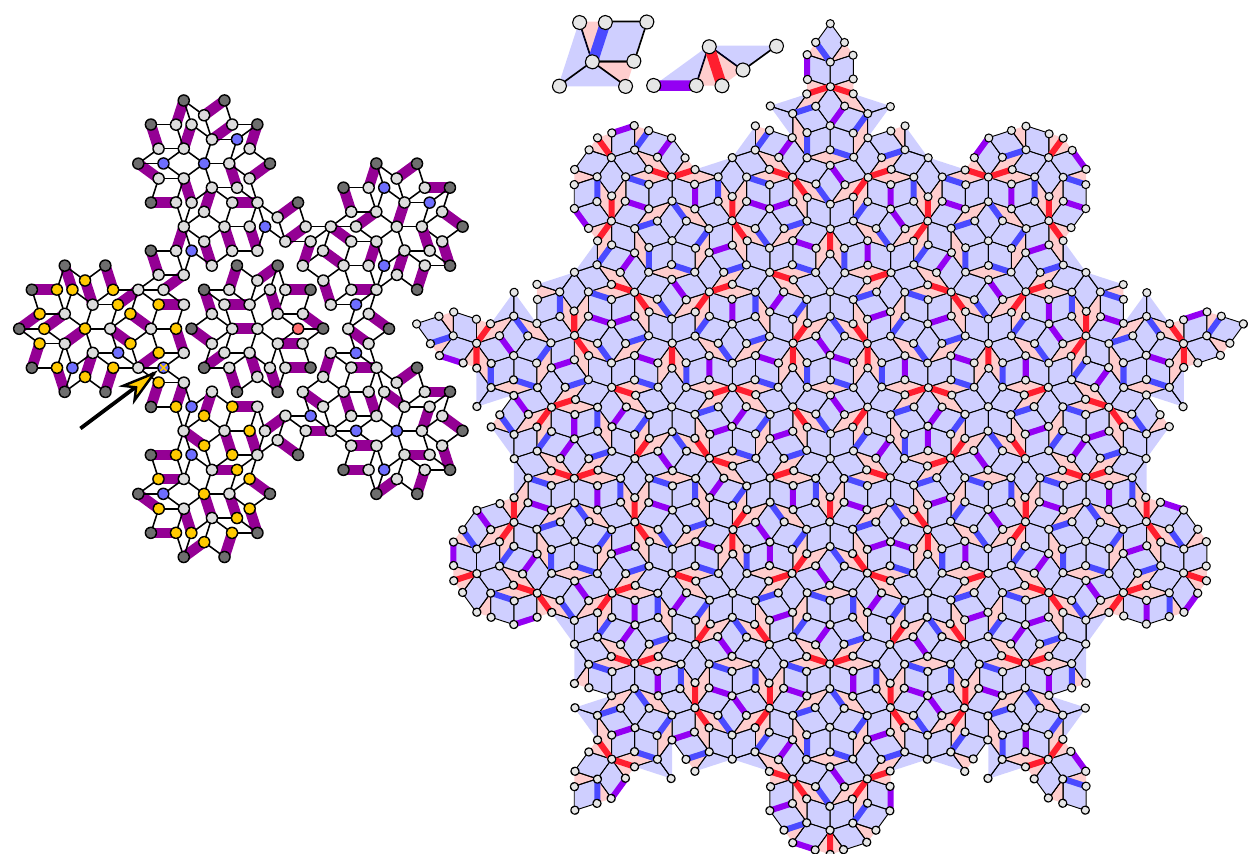
FIG. 8. (a) Deleting uncoverable edges in Fig. 7 disconnects the graph into monomer regions (the incomplete outermost region is removed). Neighboring monomer regions contain opposite net bipartite charge. The monomer indicated with a gold cross and arrow is able to reach the gold vertices by augmenting its alternating paths. It is not able to reach all vertices, even of its own charge; the obstruction is made by dimers rather than monomers (see Sec. VI). (b) Decorating the basic inflation elements with dimers in the final inflation results in the dimer covering shown. The following dimer inflation algorithm gives a maximum matching: Whenever a vertex is covered by two dimers, delete one. One monomer is then associated with each 5 -vertex with zero or one 7-vertices as second-nearest A;B -vertex with two 7-vertices as second-nearest neighbors, and three monomers are associated with each 5 A